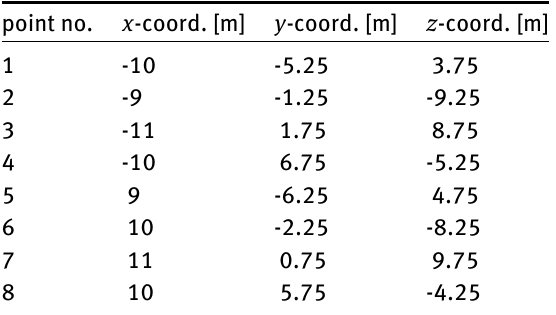
Table 11: TLS solution for plane fit in 3D